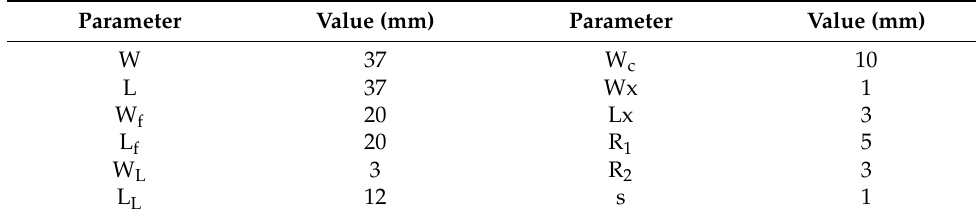
Figure 2. Top view of the proposed microstrip planar circuit geometry on an FR-4 dielectric substrate. Table 1. Proposed microstrip circuit dimensions. Table 1. Proposed microstrip circuit dimensions.